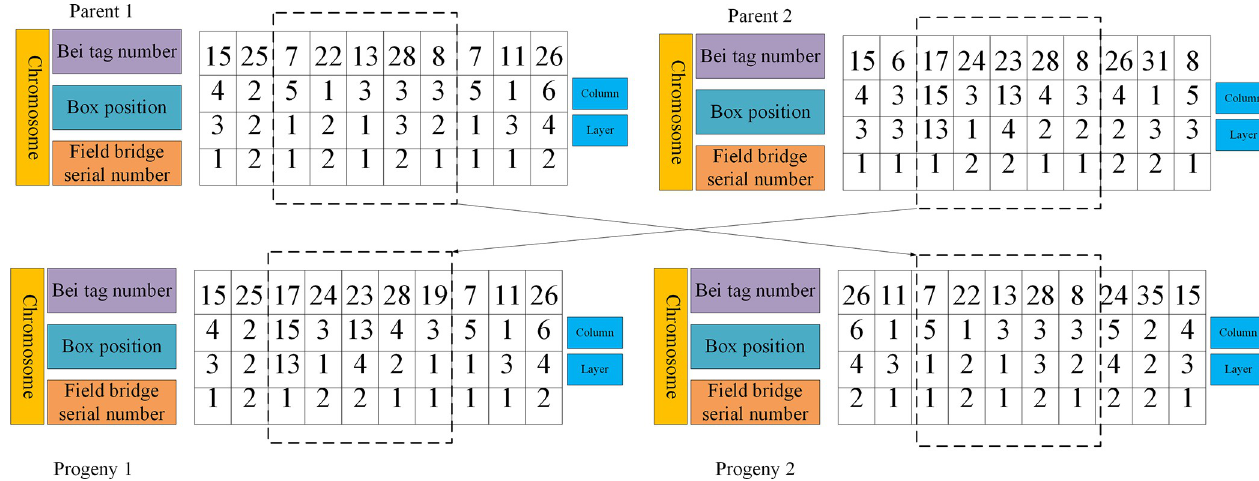
Fig 8. Schematic diagram of the crossover operation.